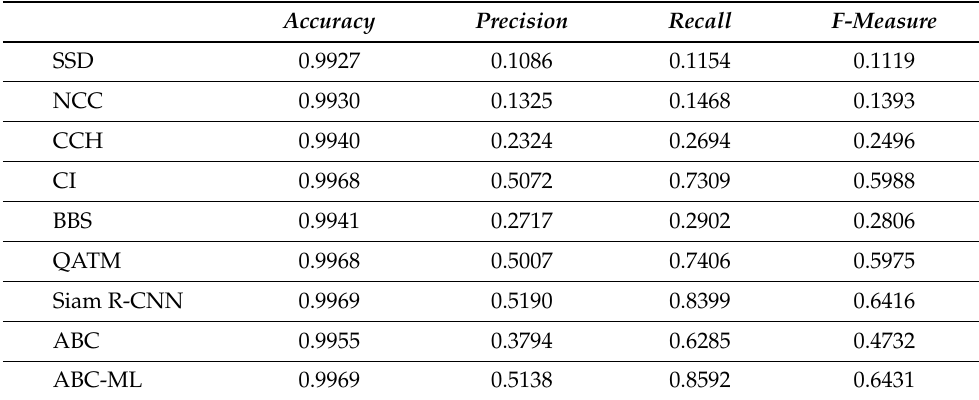
Table 3. Comparison of performance in different